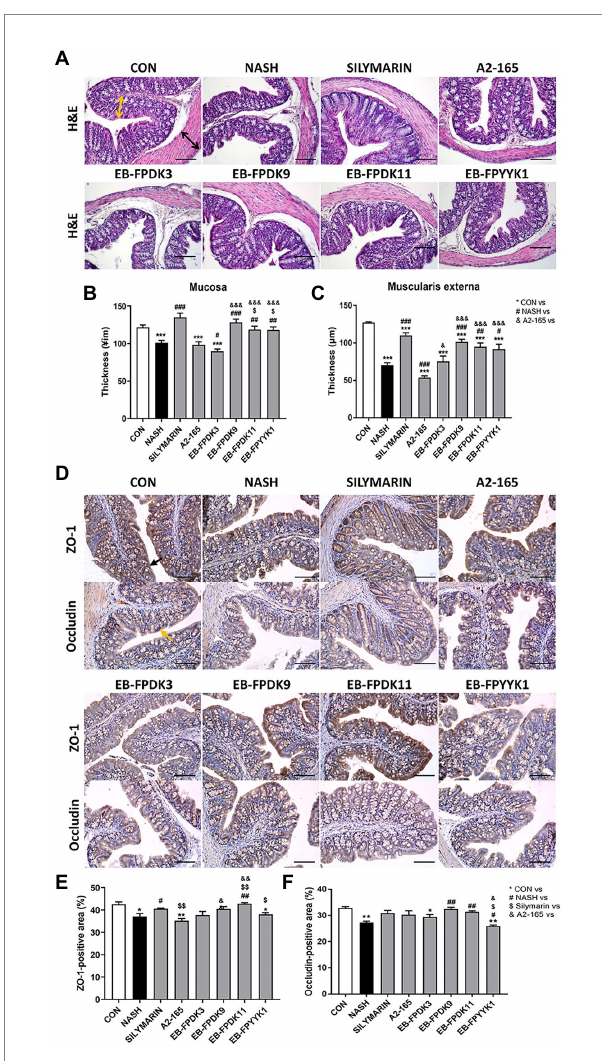
FIGURE 6 Faecalibacterium prausnitzii improves impaired gut barrier functions by modulating the tight junctions in the large intestine. (A) Microscope images of large intestine after H&E staining. Scale bar: 0.1 mm. Yellow arrows indicate the thickness of mucosa tissue, and black arrows indicate the thickness of muscularis externa tissue. (B) The thickness of the mucosa and (C) muscularis externa of the large intestine. (D) Microscope images of large intestine tissue after ZO-1 and occludin immunohistochemical staining. Scale bar: 0.1 mm. (E) The ZO-1-positive and (F) occludin-positive regions. The data are presented as the mean ± SEM ( n = 12). Statistical analyzes were performed using the Mann–Whitney U test (two-tailed) ∗ p < 0.05, ∗∗ p < 0.01, ∗∗∗ p < 0.001 versus the CON group; # p < 0.05, ## p < 0.01, ### p < 0.001 versus the NASH group; $ p < 0.05, $$ p < 0.01 versus the silymarin group; & p < 0.05, && p < 0.01, &&& p < 0.001 versus the A2-165 group. ZO-1, zonula occludens-1; CON,